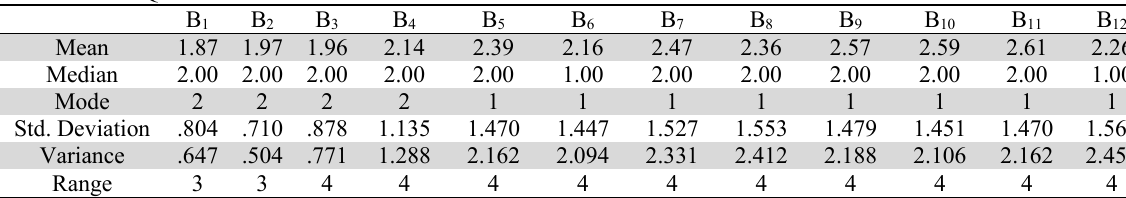
Statistics of QT&T barriers Mode Std. Deviation